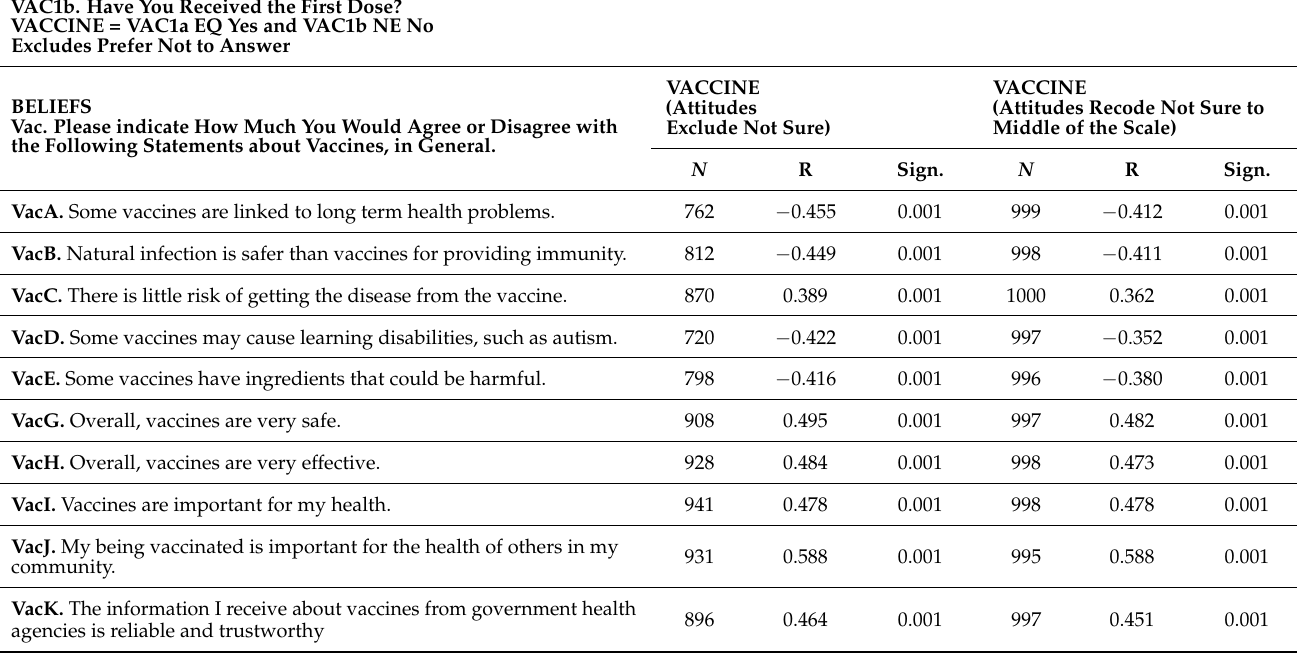
Table 2. Beliefs about vaccines and Received COVID-19